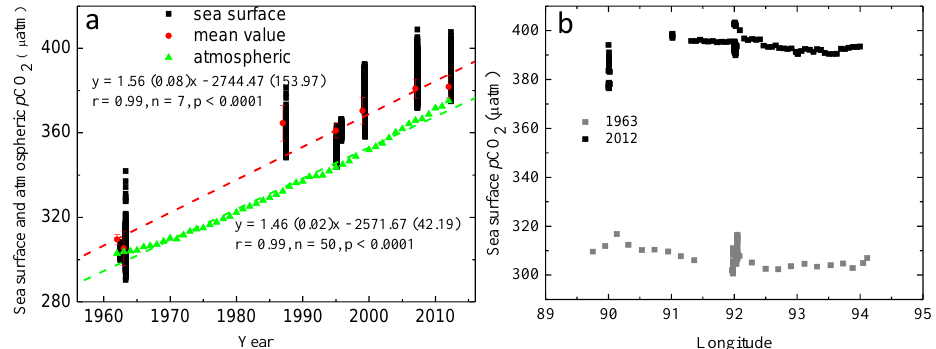
Fig. 4. Figure 4. Temporal changes in sea surface p CO 2 (black squares) and atmospheric p CO 2 (green triangles) measured at Mauna Loa, Hawaii (a) , and sea surface p CO 2 along the Equator during April 1963 and May 2012 (b) . The dashed line in (a) shows the linear regression line based on the mean value of each cruise (red circle), which has been deseasonalized using the climatological data identified by Takahashi et al. (2009).